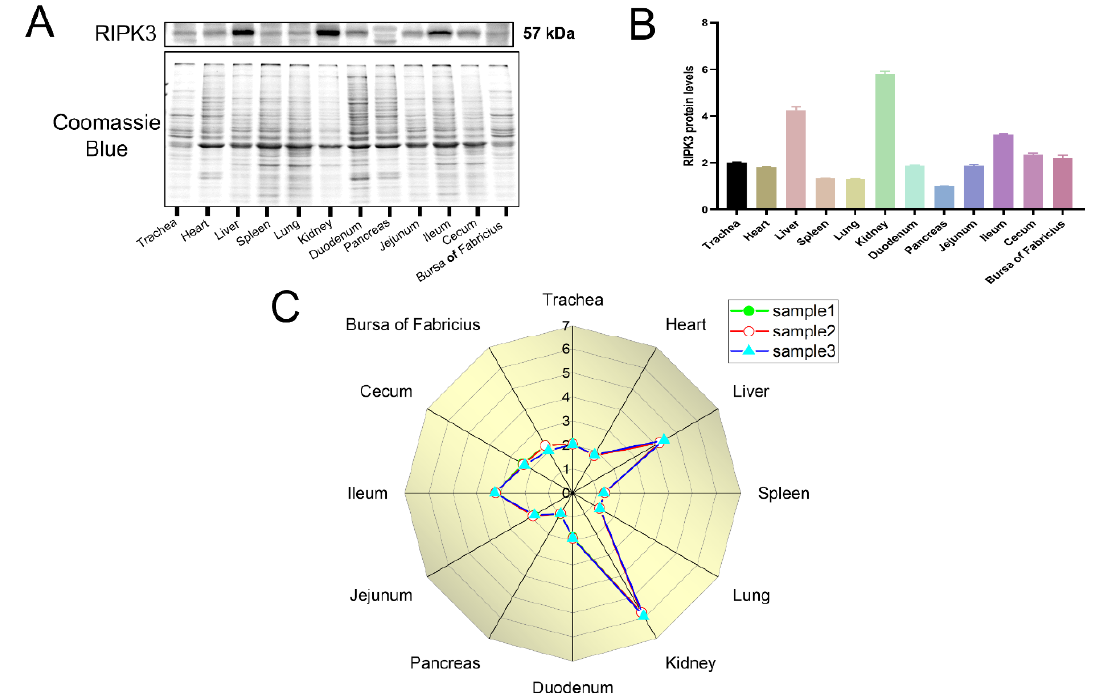
Figure 5. Expression levels of RIPK3 protein in different organs of 28-day-old Hy-line laying chickens ( n = 3). ( A ) Western blot explores the expression levels of the target protein in twelve tissues in the chickens. ( B ) The expression levels of RIPK3 relative to the total protein stained with Coomassie Blue. ( C ) Radar chart analysis of RIPK3 protein levels.